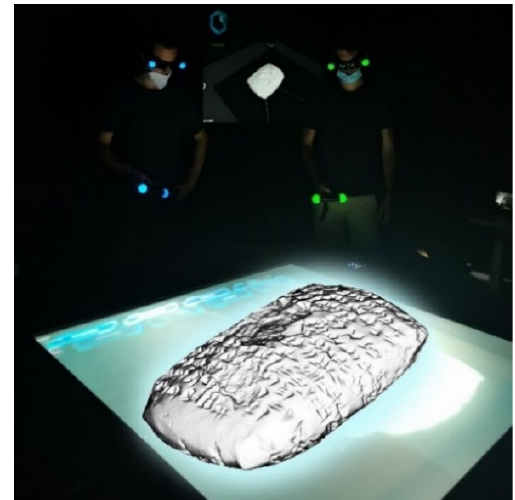
Figure 12. 727 cuneiform tablet holographic visualization.